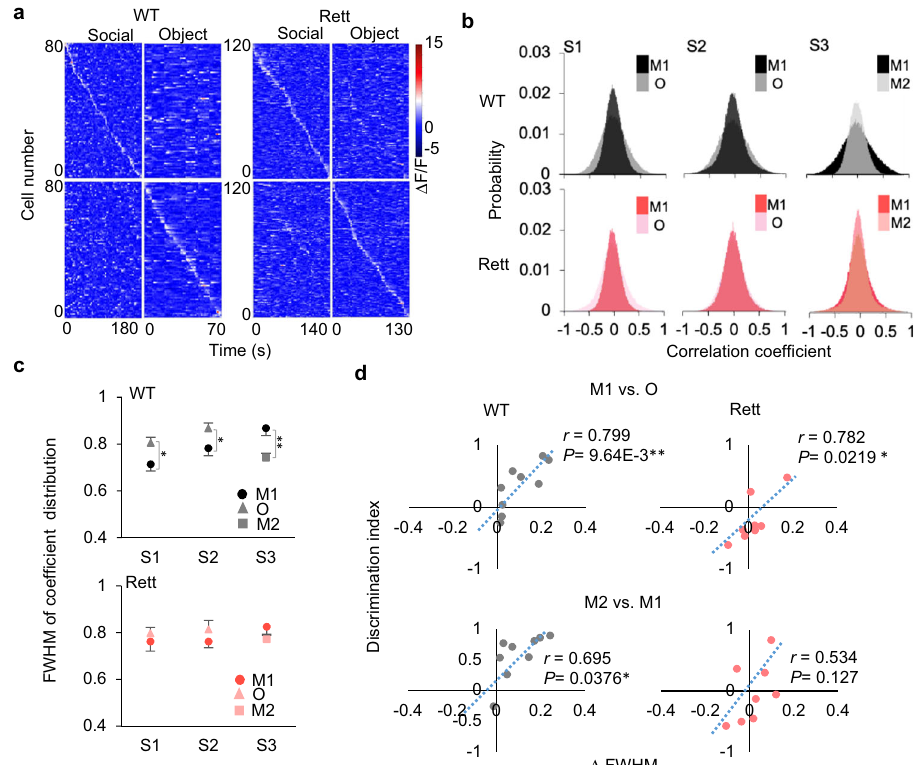
Fig. 4 Pattern decorrelation enables social preference in WT mice but is impaired in Rett mice. a Raster plots of calcium activity of individual mPFC neurons during interactions with different stimuli, from representative WT and Rett mice. Calcium transient traces are sorted by the peak activity time of social interaction (left top) and object interaction (right bottom), while the calcium traces of those sorted neurons in responding to object (top right) and social (bottom left) stimuli were also plotted in the same sequence of the sorted plot. b Distribution of pair-wise Pearson correlation coef fi cients among all recorded mPFC neurons of WT ( Mecp2 + / + ; n = 9) and Rett ( Mecp2 + / − ; n = 8) mice in responding to stimuli in each session. The black and red plots represent M1 interactions, while the lighter colors (grey and pink) represent the interaction with the other stimulus (O or M2). c The averaged full width at half maximum (FWHM) of correlation coef fi cient distribution (b) of individual WT mice ( n = 9) and Rett mice ( n = 8) during interactions with different stimuli. Data are represented as mean ± SEM. * P < 0.05, ** P < 0.01, two-way RM ANOVA with Bonferroni – corrected post hoc comparisons. d The relationship between Δ FWHM and the discrimination index in each mouse, by genotype. In Rett, the Δ FWHM is centered around zero, meaning little or no decorrelation; the discrimination index is mostly below zero. n = 9 WT and 8 Rett mice. Each dot represents an individual mouse; Pearson ’ s